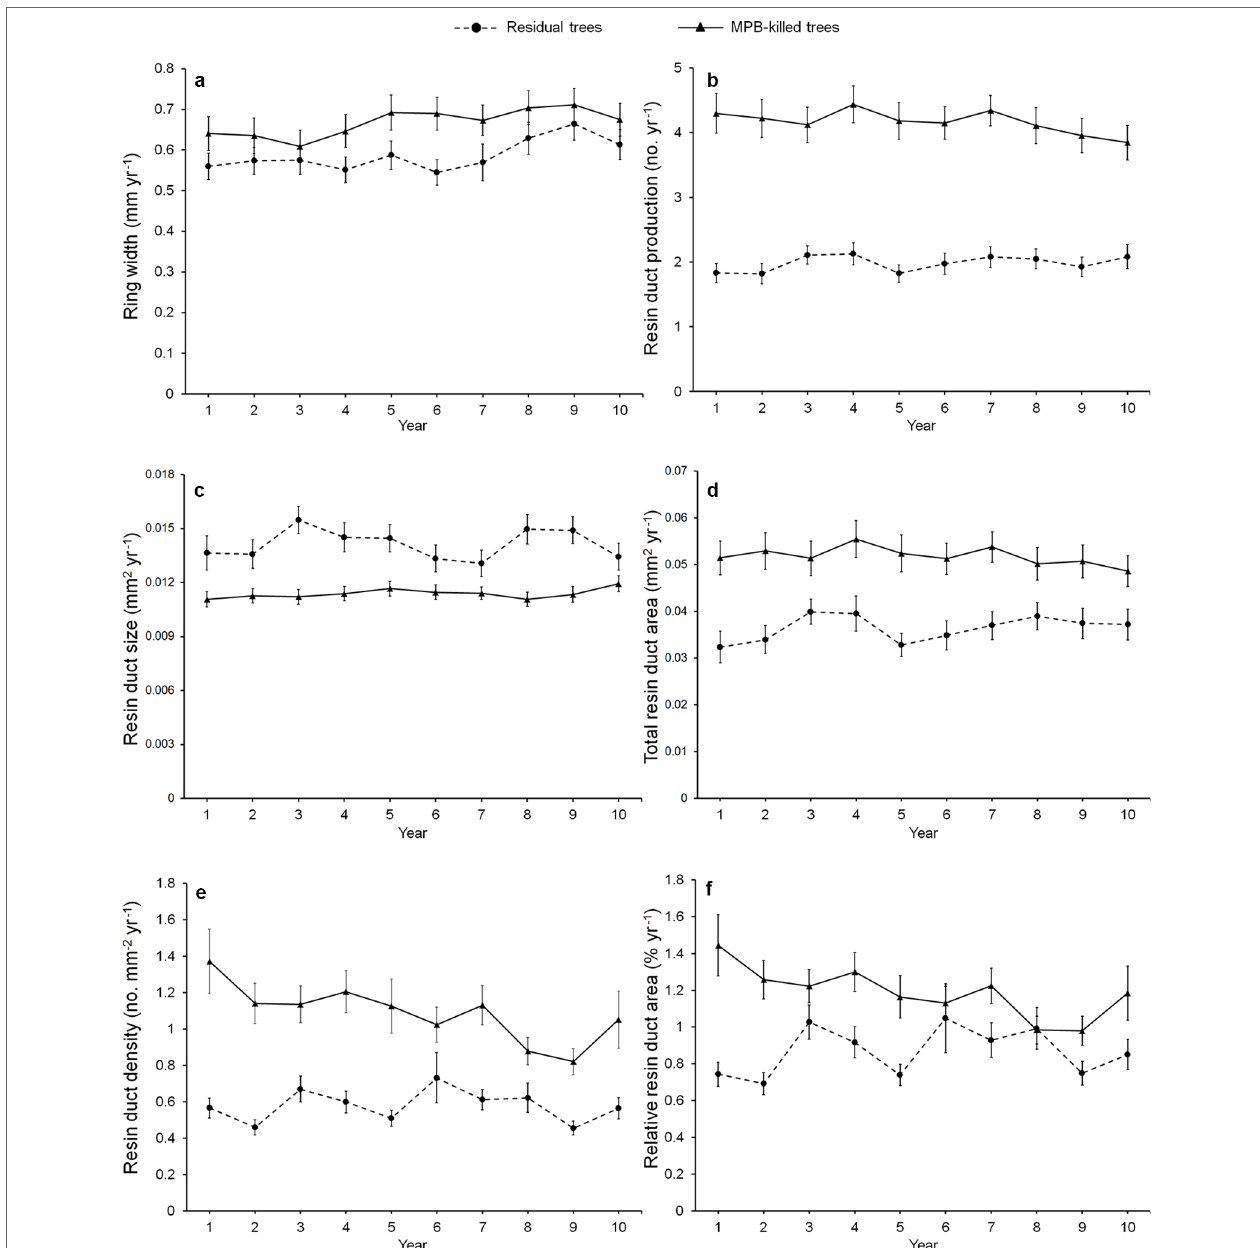
FIgURe 1 | Annual variation in the mean of ring width (a) , resin duct production (b) , resin duct size (c) , total resin duct area (d) , resin duct density (e) , and relative resin duct area (f) of residual and killed Pinus contorta var. latifolia trees in the 10 years before mountain pine beetle (MPB, Dendroctonus ponderosae ) outbreak. We did not use calendar years because the starting year of MPB outbreak varied among sites and the year of trees killed varied among trees.